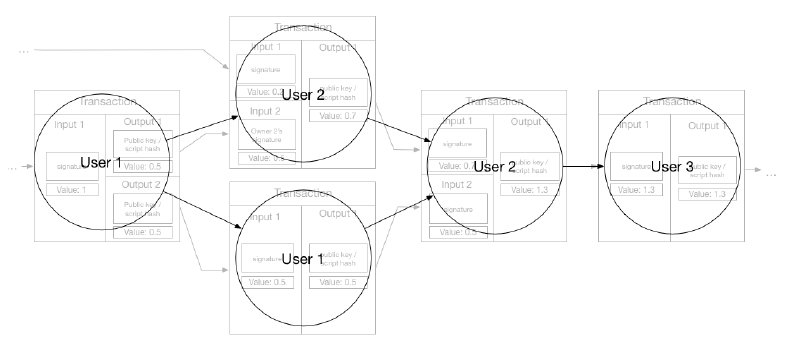
Figure 3. User network after linking